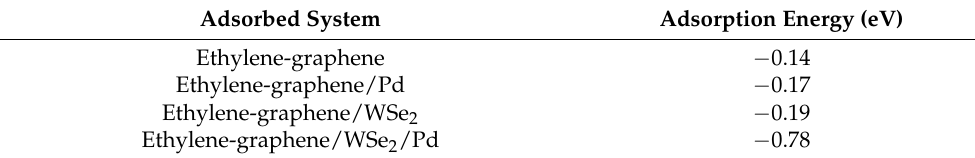
Table 2. Adsorption energies of the ethylene adsorption